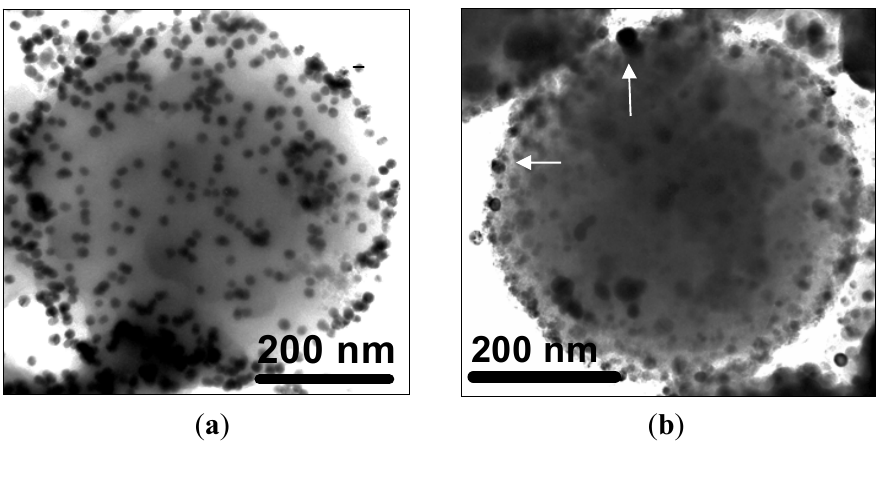
Figure 5. TEM images of: ( a ) Au-coated NPGMSi-1; and ( b ) Au-coated NPGMSi-2 (white arrows indicate Au